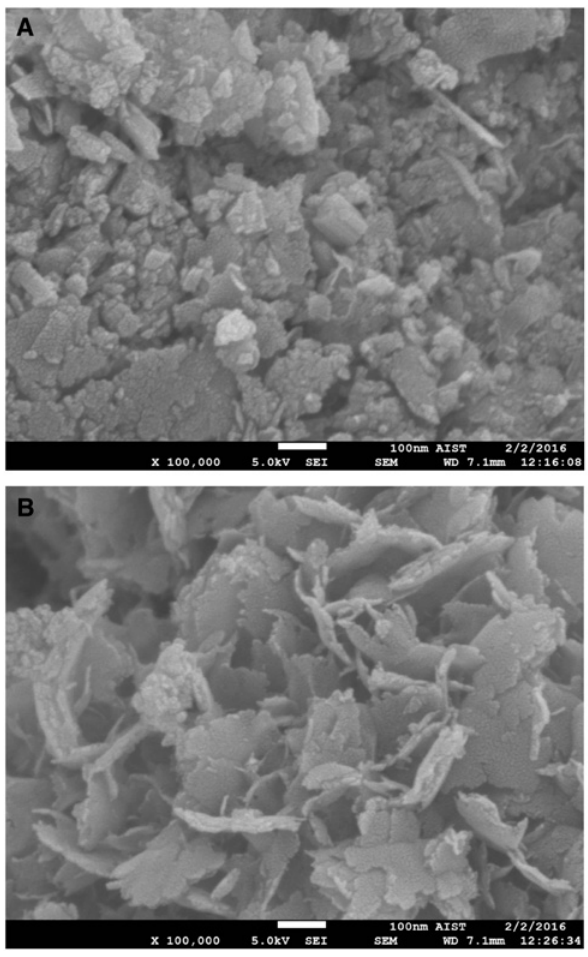
Figure 2: SEM images of before and after the denaturing process of laterite ore: (A) natural laterite ore, (B) manganese-doped